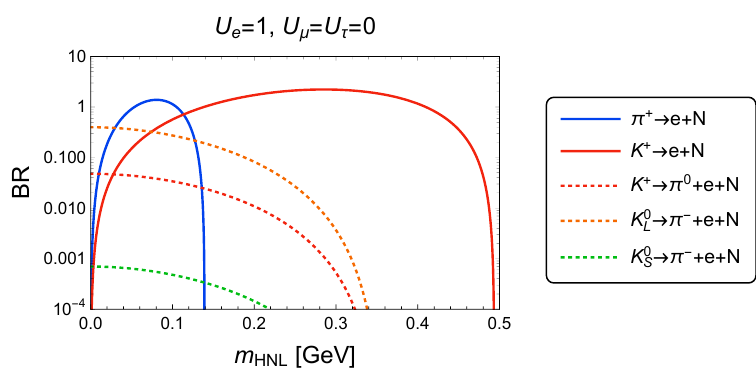
Figure 13 . Dominant branching ratios of HNL production from light mesons. In this figure, we take U = 1 , U = U = 0 . The decay width to HNLs are normalized by experimental values of e µ τ the total decay width of mesons. Below the kaon mass, the HNL productions are dominated by the leptonic decays of pions and kaons.